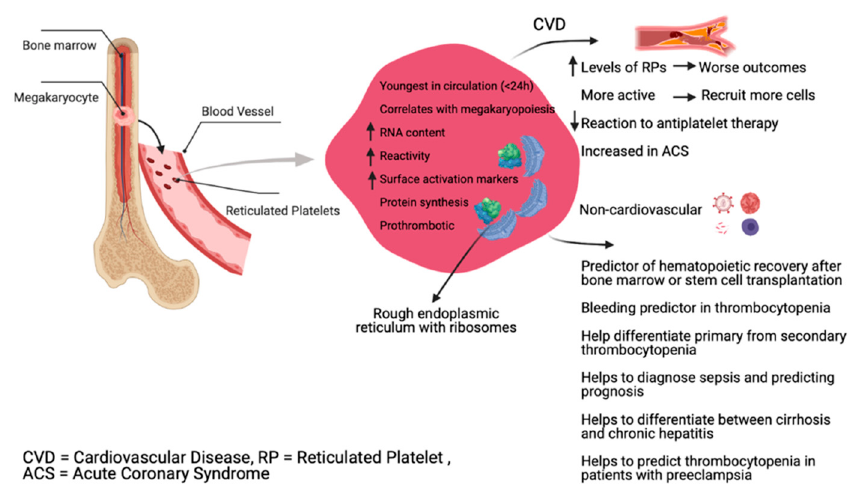
Figure 1. RP properties and roles in different diseases.